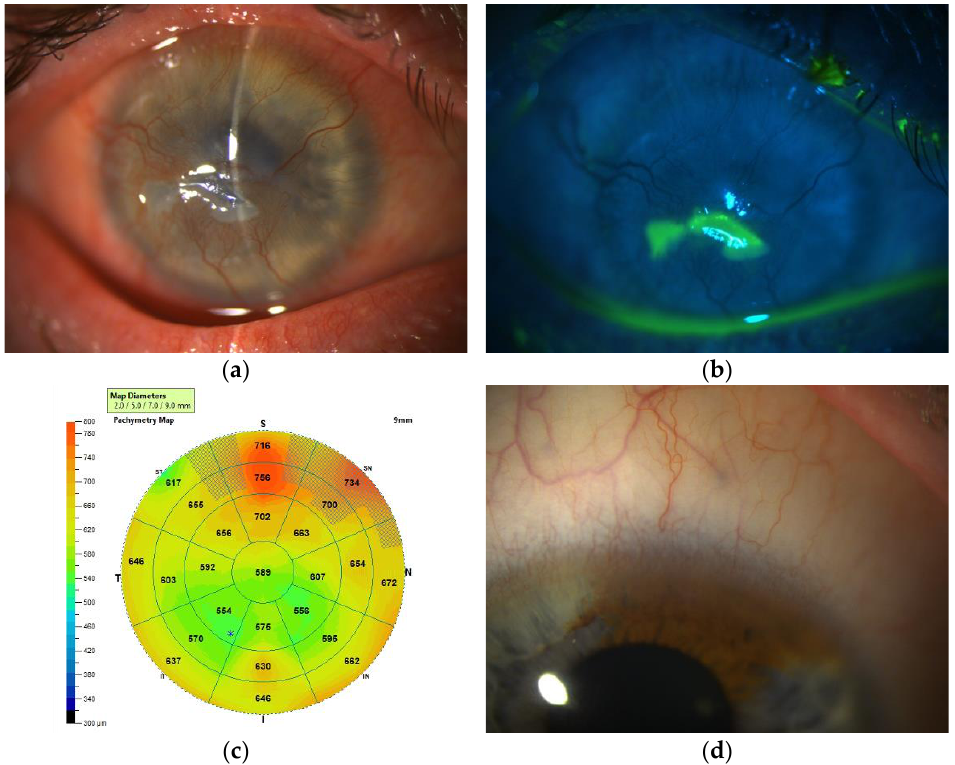
Figure 2. Slit-lamp biomicroscopy with and without fluorescent staining in a patient with unilateral